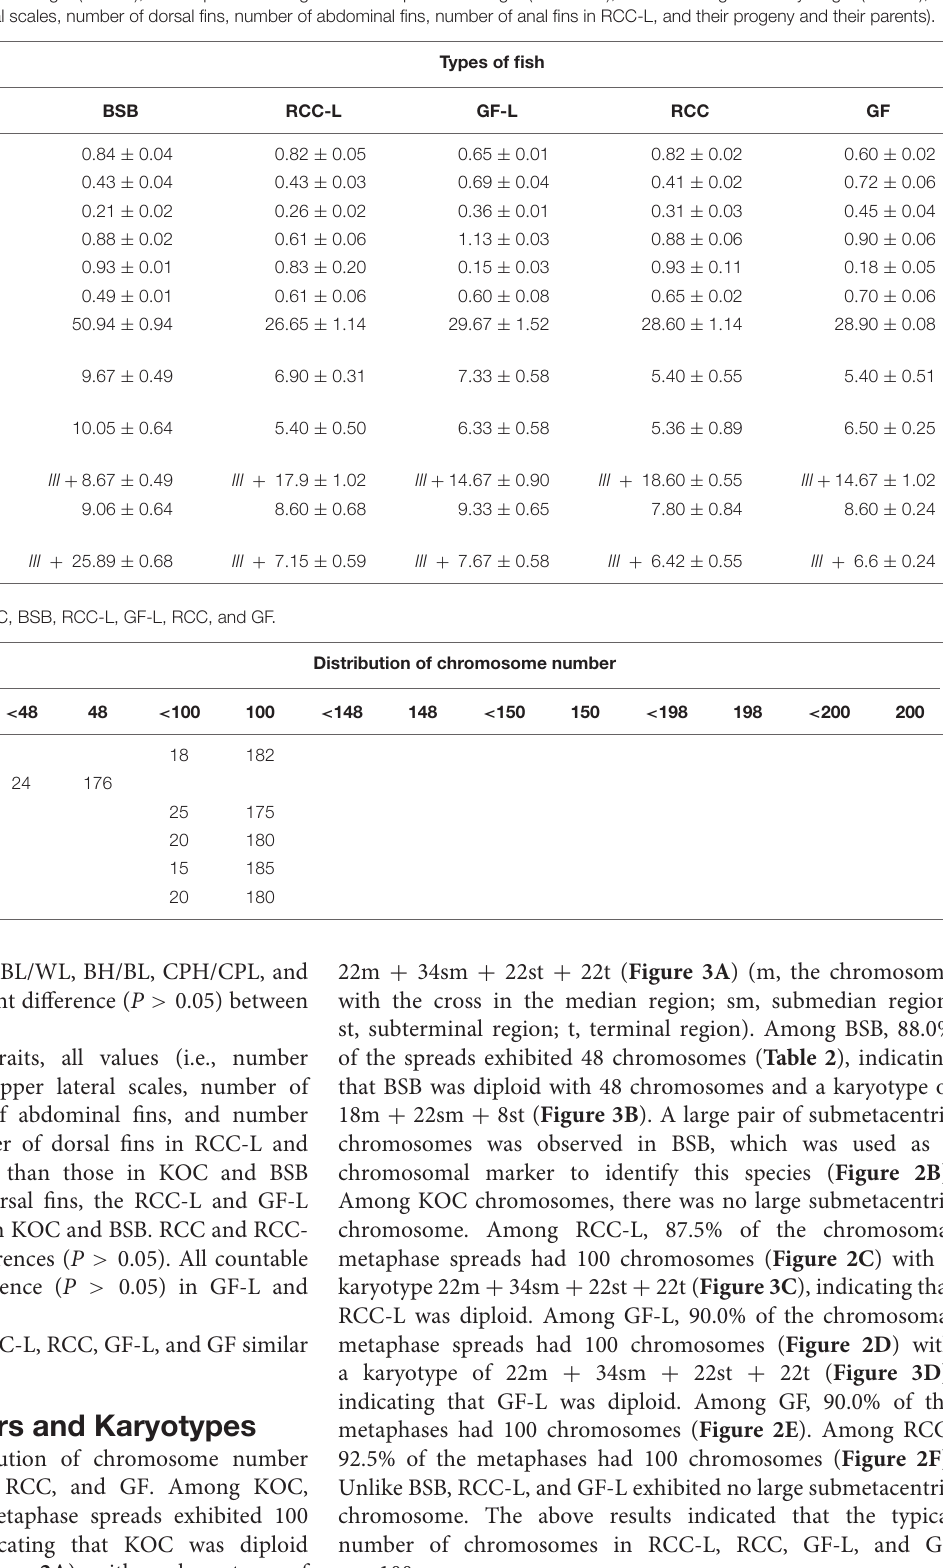
TABLE 1 | The phenotypes including the measurable traits (the average ratios of body length to whole length (BL/WL), body height to body length (BH/BL), head length to body length (HL/BL), head height to head length (HH/HL), caudal peduncle height to caudal peduncle length (CPH/CPL), and head height to body height (HH/BH), and the countable traits (number of lateral scales, number of dorsal fins, number of abdominal fins, number of anal fins in RCC-L, and their progeny and their parents).